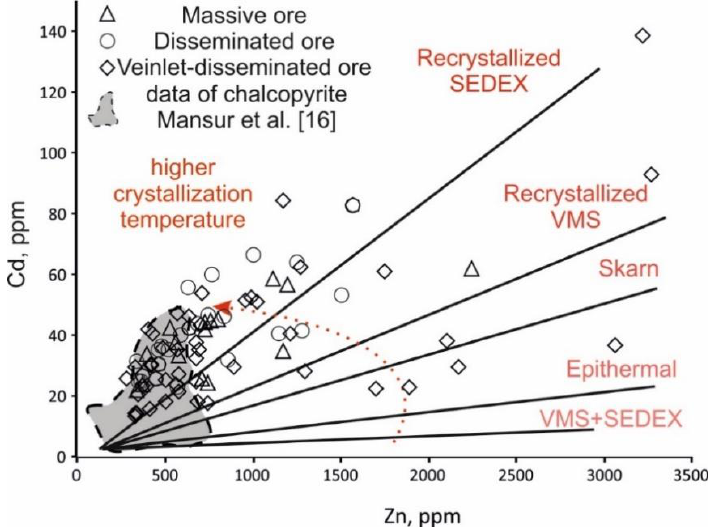
Figure 10. Binary classification diagram based on Cd and Zn concentrations in chalcopyrite from the Oktyabrsk deposit, suggested by the authors of [1].